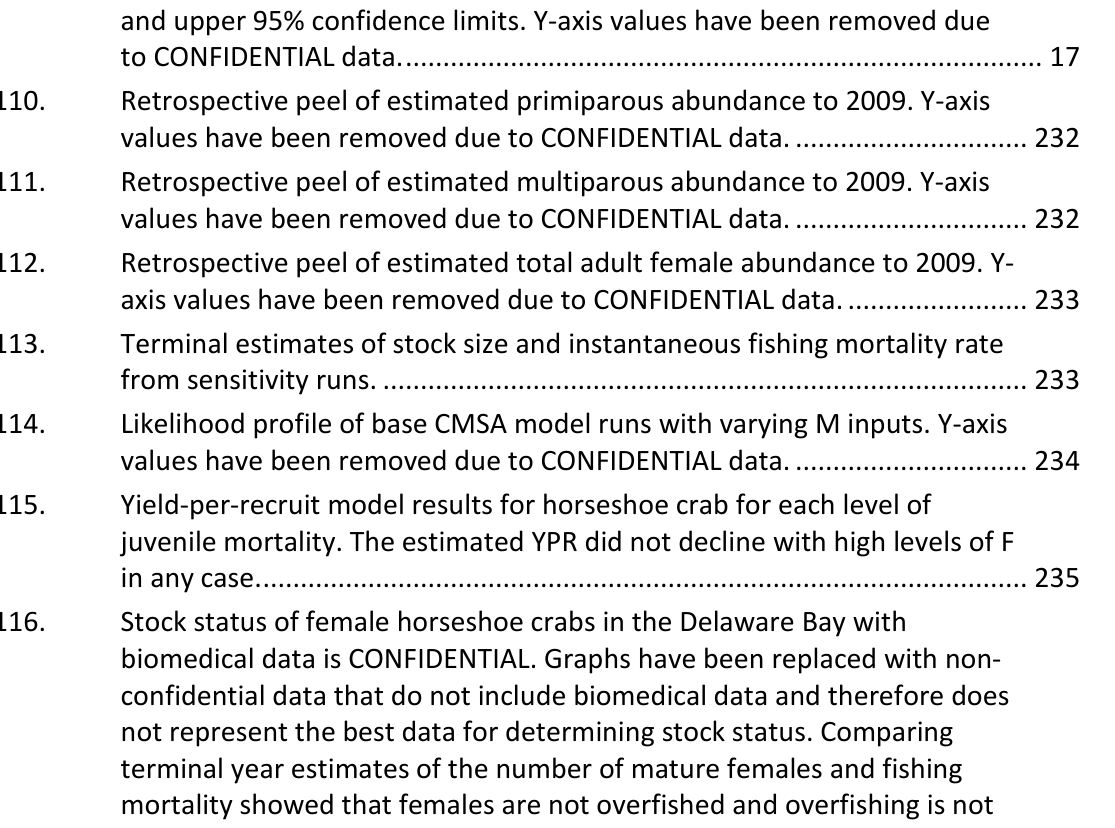
Figure 109. CMSA model estimated instantaneous fishing mortality rate F with lower and upper 95% confidence limits. Y-axis values have been removed due Figure 110. Retrospective peel of estimated primiparous abundance to 2009. Y-axis Figure 111. Retrospective peel of estimated multiparous abundance to 2009. Y-axis Figure 112. Retrospective peel of estimated total adult female abundance to 2009. Y- Figure 113. Terminal estimates of stock size and instantaneous fishing mortality rate Figure 114. Likelihood profile of base CMSA model runs with varying M inputs. Y-axis Figure 115. Yield-per-recruit model results for horseshoe crab for each level of juvenile mortality. The estimated YPR did not decline with high levels of F Figure 116. Stock status of female horseshoe crabs in the Delaware Bay with biomedical data is CONFIDENTIAL. Graphs have been replaced with non- confidential data that do not include biomedical data and therefore does not represent the best data for determining stock status. Comparing terminal year estimates of the number of mature females and fishing mortality showed that females are not overfished and overfishing is not occurring. The horizontal lines on the graphs indicate the reference points ( B MSY and F MSY ) generated from the theoretical population Figure 117. Sex ratio of Delaware Bay horseshoe crabs from the Delaware Bay spawning survey. The terminal year sex ratio was greater than the 2.0 reference point indicating that the male population is not overfished and there was no declining trend in the sex ratio indicating that